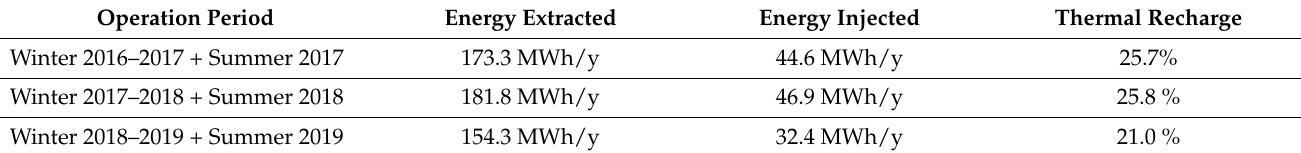
Table 5. Annual values of the energy extracted and injected and related thermal recharge (source: [22]). Operation Period Energy Extracted Energy Injected Thermal